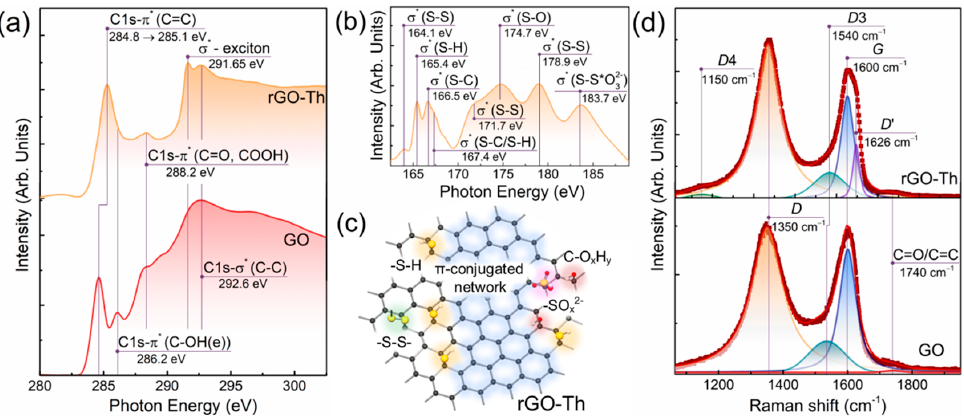
Figure 2. Chemistry and structure of rGO–Th. ( a ) C K -edge and ( b ) S L -edge X-ray absorption spectra of the initial GO and rGO–Th. ( c ) Schematic representation of rGO–Th. ( d ) Raman spectra of the initial GO and rGO–Th.